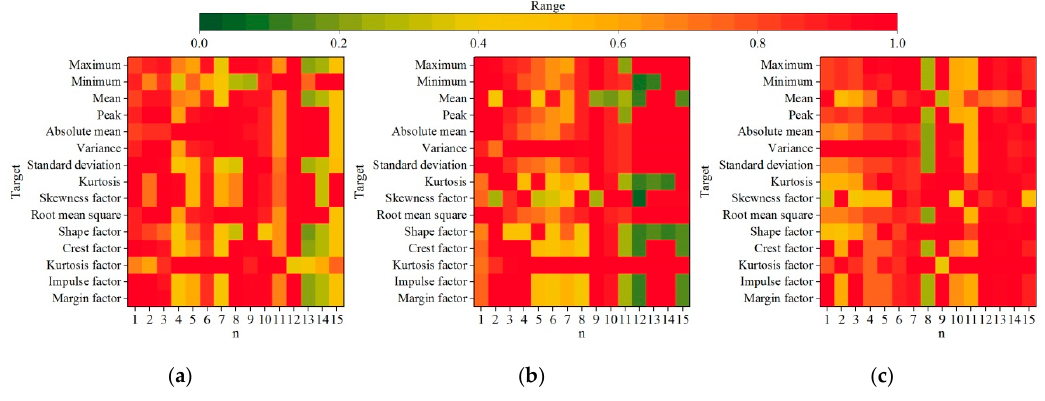
Figure 6. Heat map of translated value: ( a ) 40 m 3 /h, ( b ) 50 m 3 /h, ( c ) 60 m 3 /h.